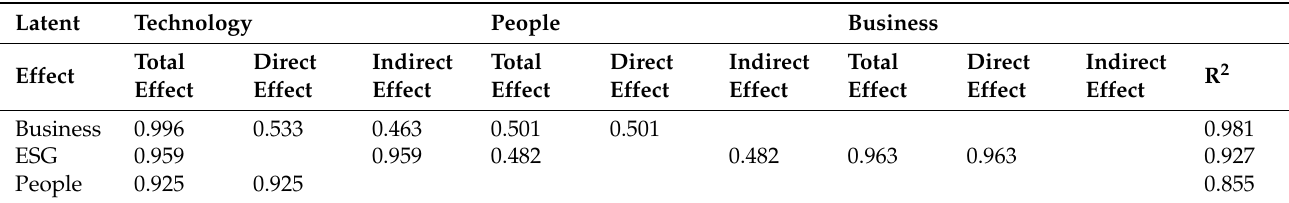
Table 10. The result of the path analysis of the direct and indirect